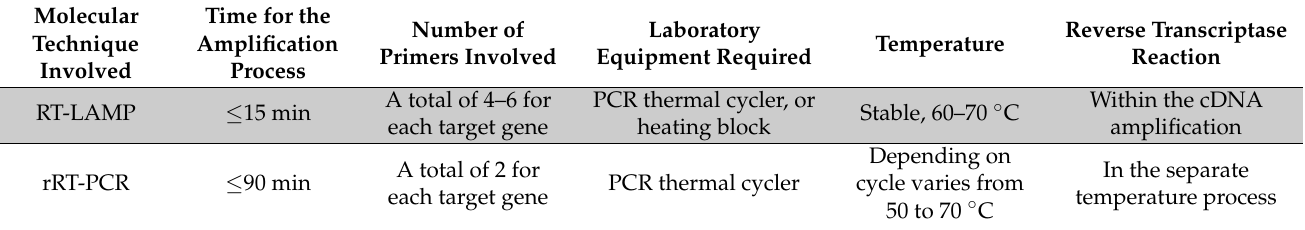
Table 2. Comparison of the RT-LAMP and rRT-PCR